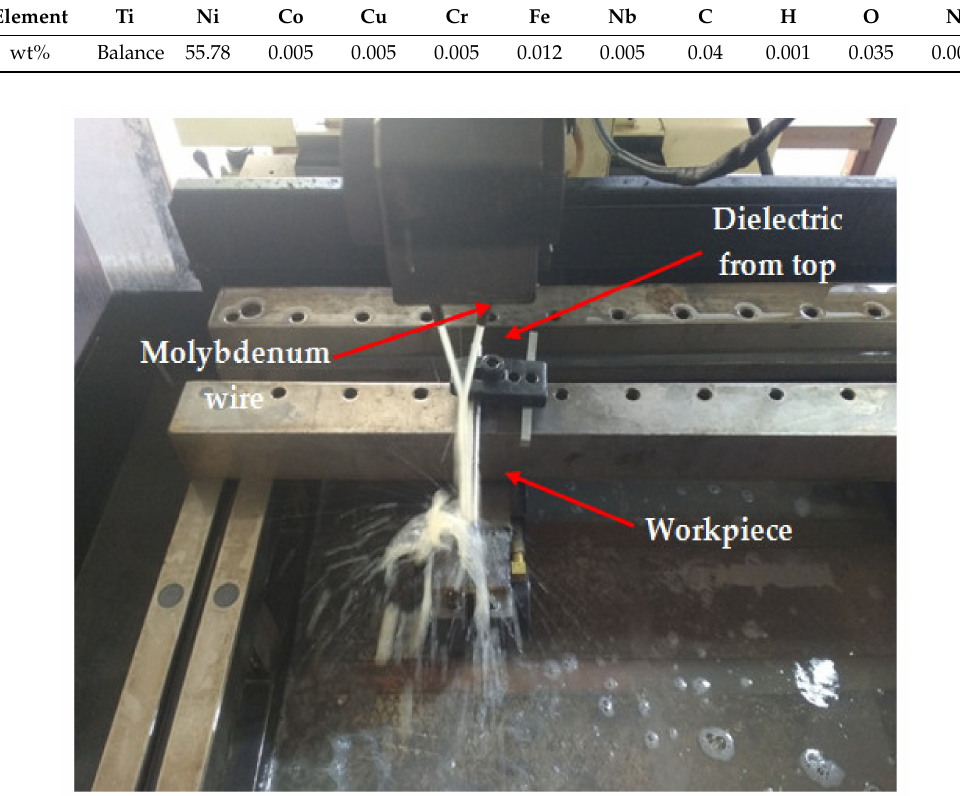
Figure 1. Representation of wire-electrical-discharge-machining(WEDM) process with flushing